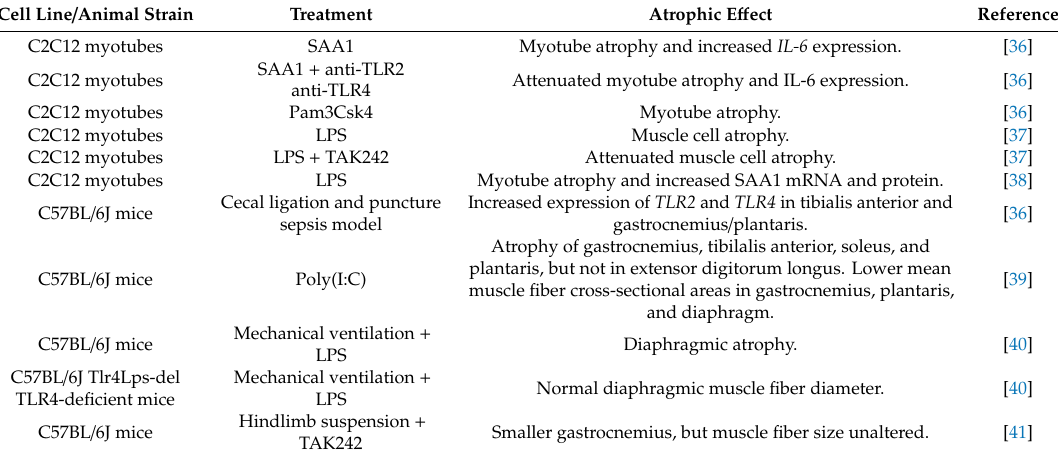
Table 1. E ff ects of Toll-like receptor (TLR) pathway manipulation on muscle atrophy in vitro and in